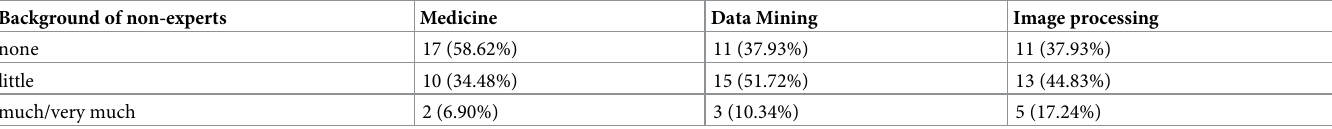
Table 2. Expertise of the 29 experiment participants in medicine, data mining, image processing. Background of